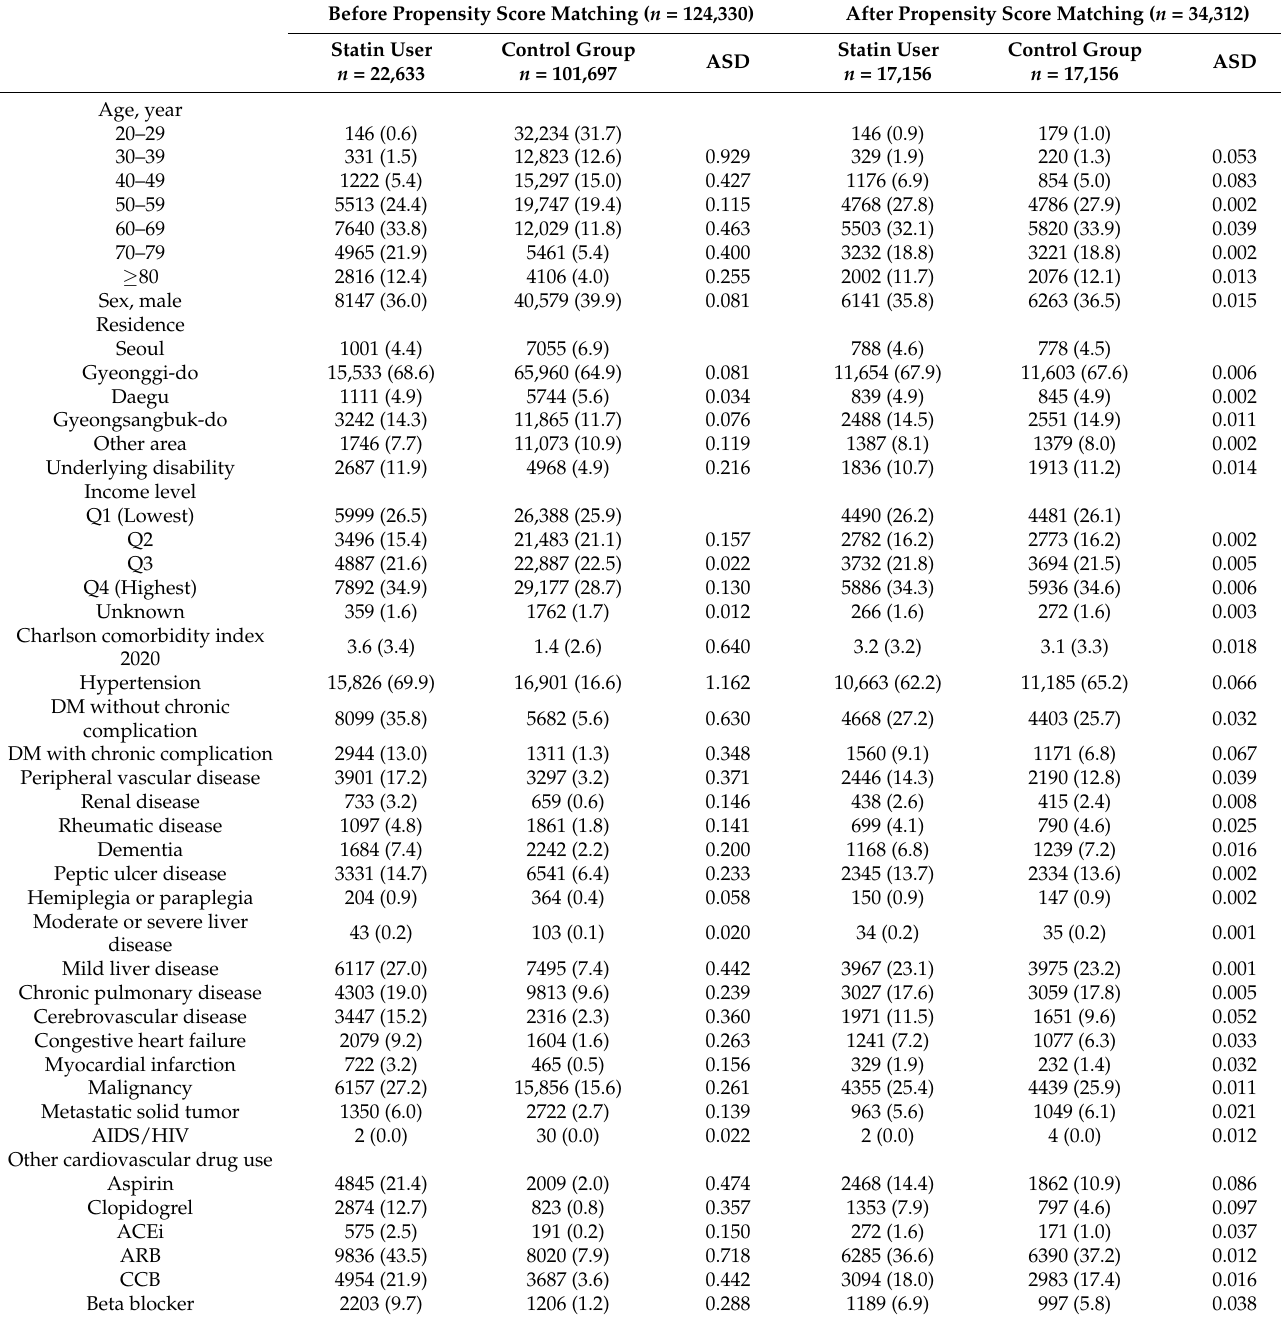
Table 1. Comparison of characteristics between statin users and the control group before and after propensity score